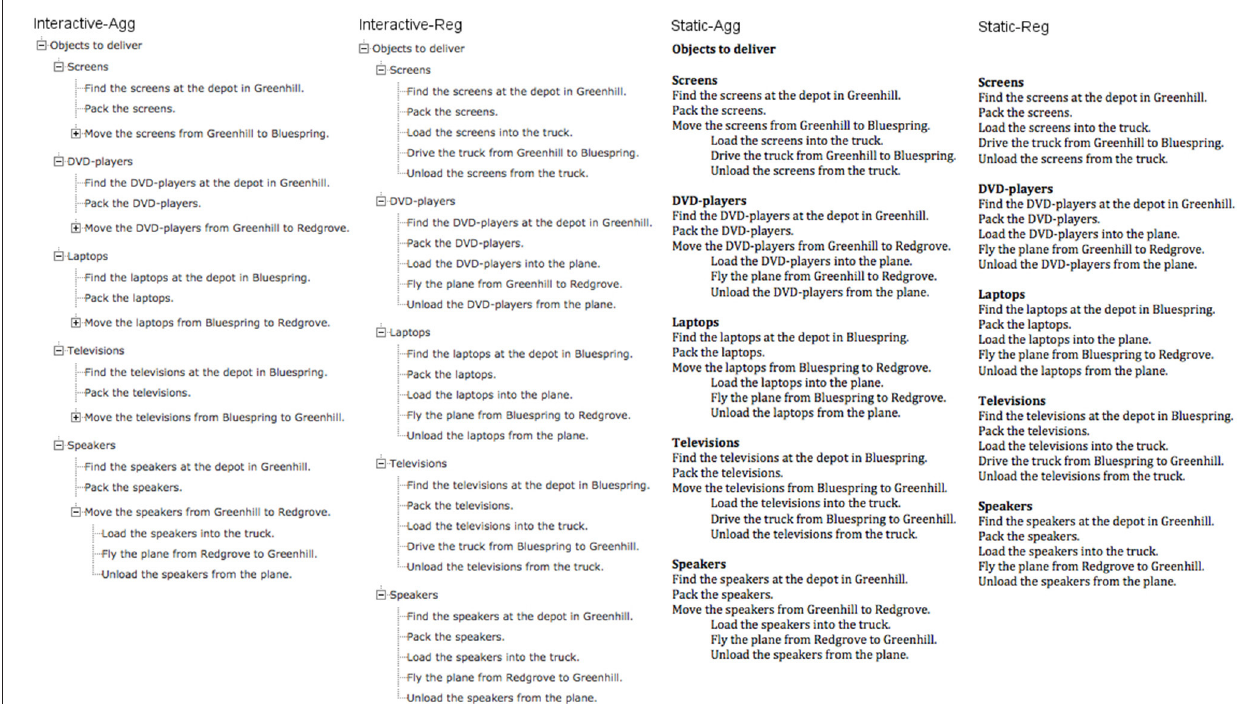
FIGURE 2 | The four conditions used in Experiment